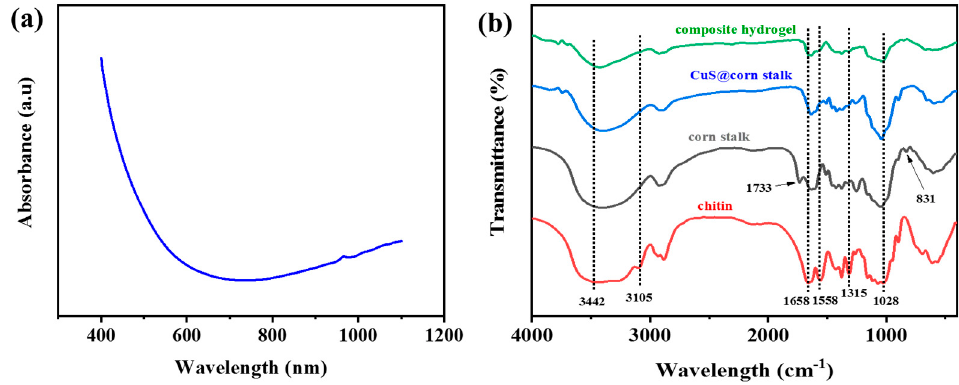
Figure 2. ( a ) UV-vis absorption spectrum of CuS; ( b ) FT-IR spectra of the composite hydrogel, CuS@corn stalk, corn stalk and chitin.